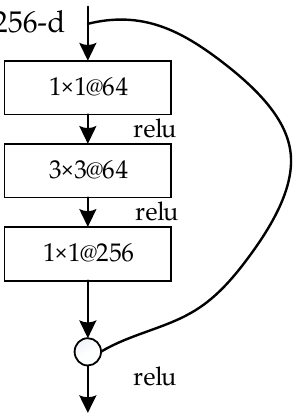
Figure 4. Resnet101 residual network connection mode. At the same time, in order to realize the fusion of high-level image features and low- level image features, the feature pyramid could realize prediction on any feature layer of the image. The network structure of the feature pyramid is shown in Figure 5. The blue box represents the feature map, and the thickness of the box represents the semantic